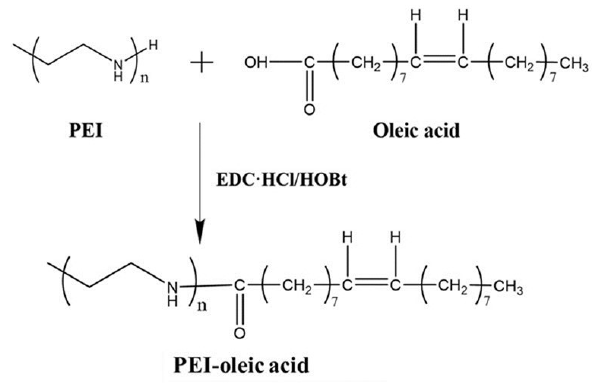
Figure 1. Synthesis of amphiphilic molecule PEI-oleic acid.